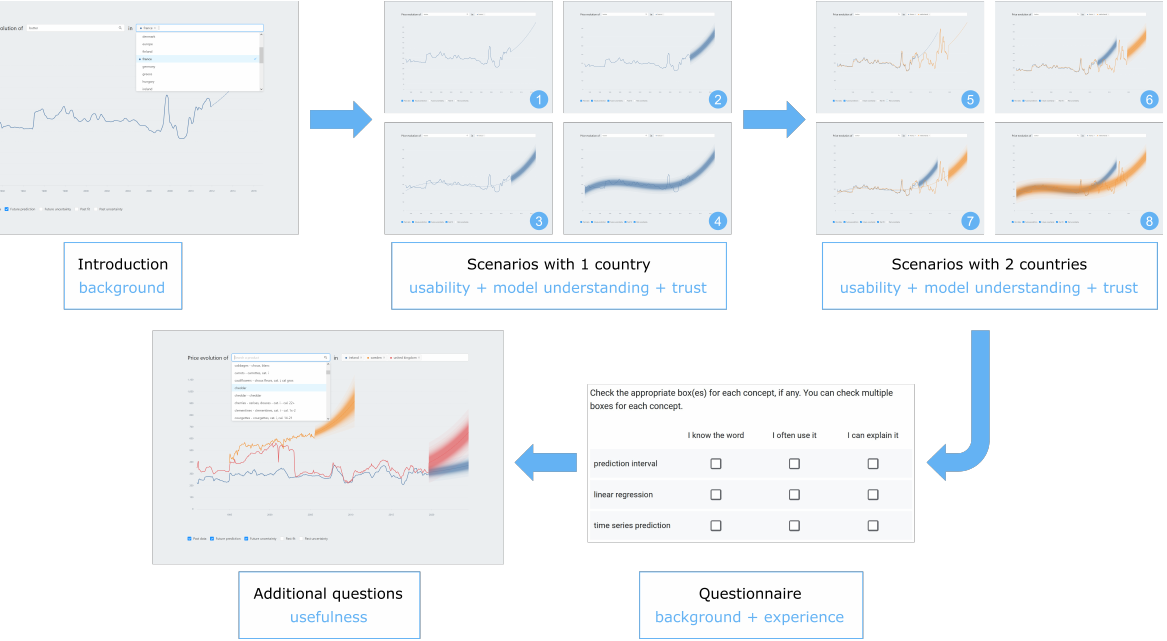
Figure 2. The flow of our study, including 5 phases: an introduction, four scenarios with one country, four scenarios with two countries, a questionnaire, and additional